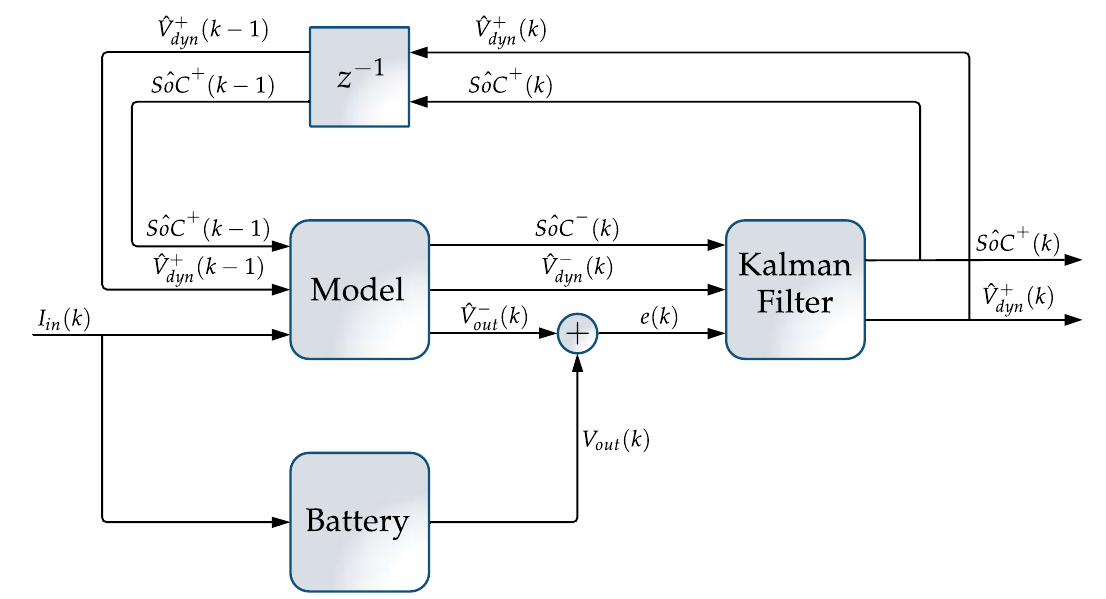
Figure 3. Block diagram of the stochastic non-linear SR-UKF state observer applied to the battery